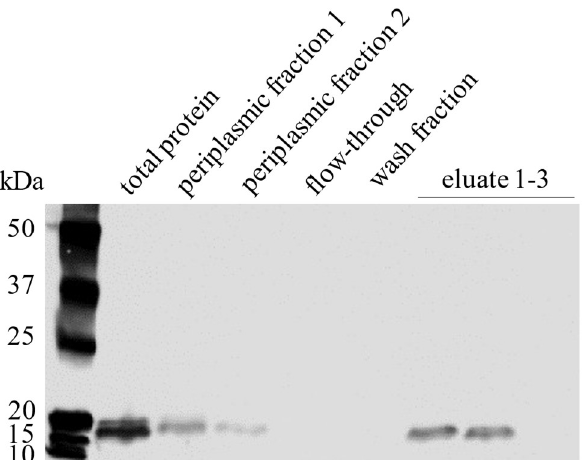
Figure 6. Western blot of expressed VHH_19 and its presence in purification steps. Following sam- ples, total protein, periplasmic fraction 1 and 2, flow–through, wash fraction, and eluate 1–3 were collected after the expression and during the Ni–NTA purification process. Protein samples were separated on a 12% TGX gel (BioRad) by SDS–PAGE and transferred to a nitrocellulose membrane by semi–dry WB. The detection of VHH_19 was performed using a primary anti–HA–tag antibody diluted 1:5000 in TBS–T/5% goat serum. The primary antibody was detected by an HRP-conjugated goat anti-mouse IgG Fc ɣ antibody diluted 1:10,000 in TBS–T/5% goat serum. Precision Plus Protein TM WesternCTM Standard (BioRad, München, Germany) was used as a protein standard molecular weight marker (first lane).